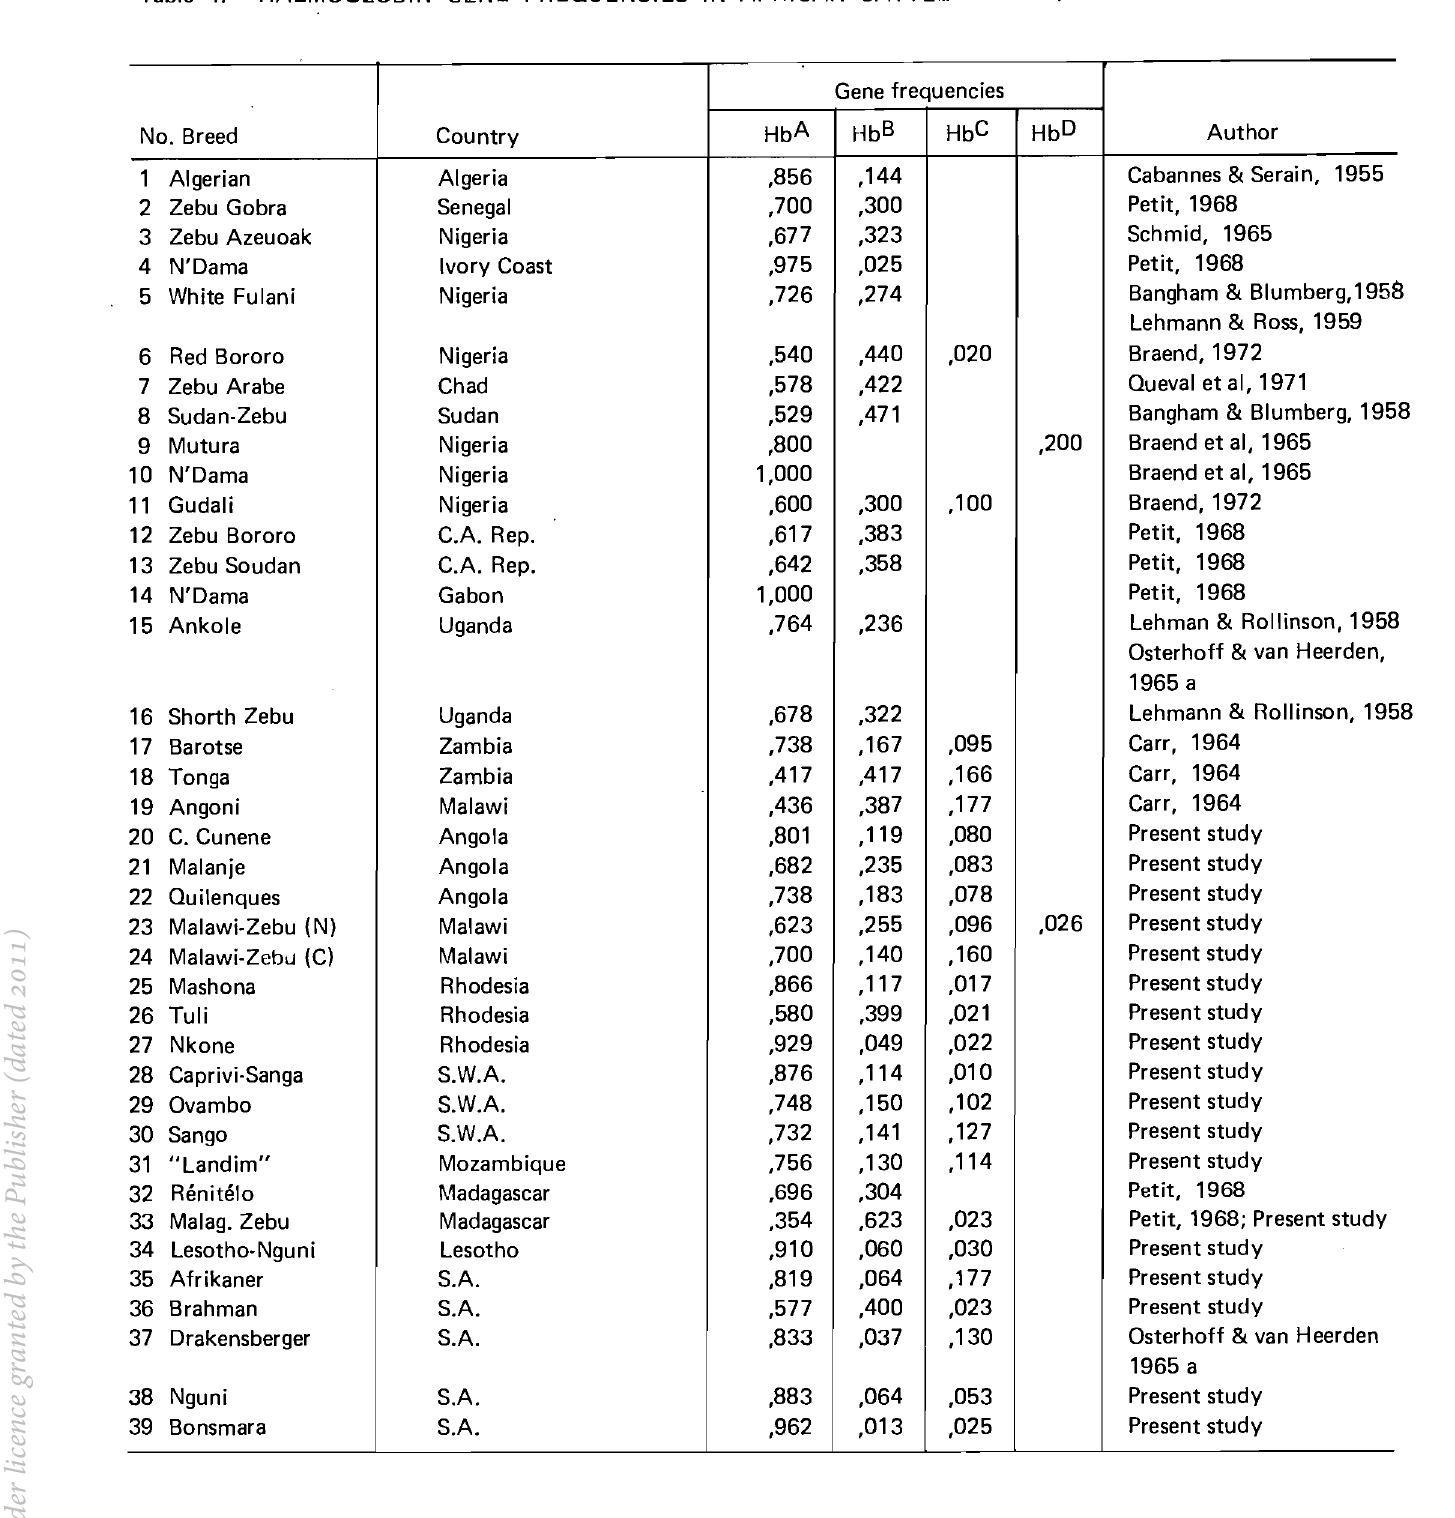
Table 4: HAEMOGLOBIN GENE FREQUENCIES IN AFRICAN CATTLE